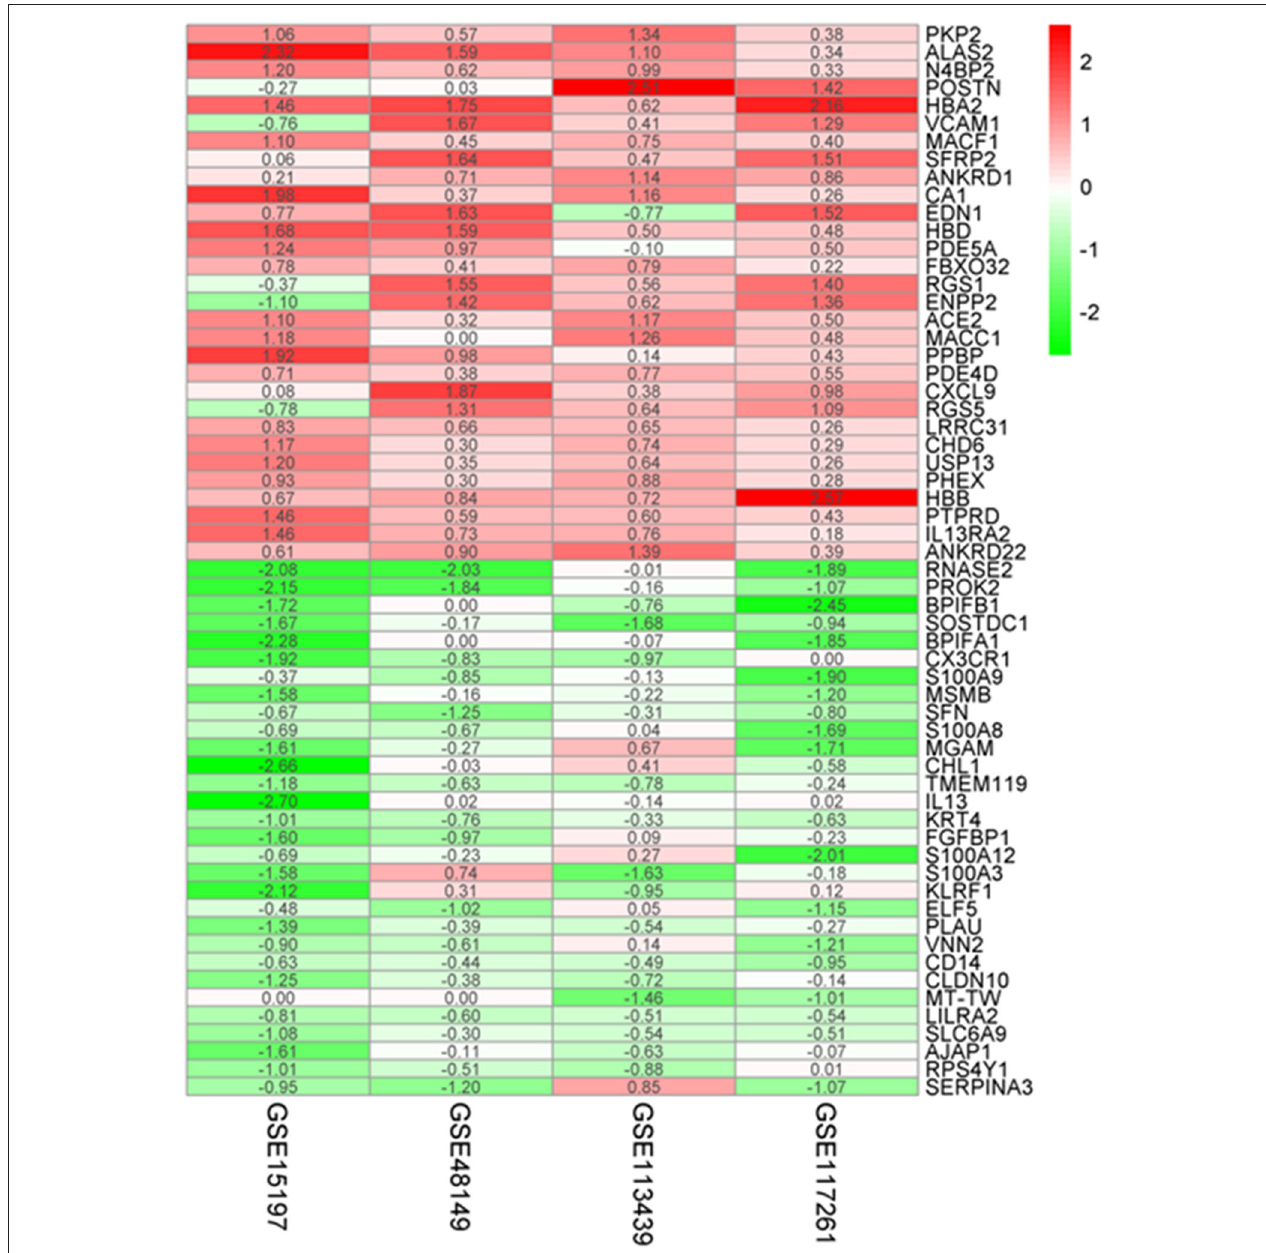
FIGURE 2 | Robust DEGs identified by RRA analysis. Heatmap of the four datasets showing the top 30 upregulated and 30 downregulated DEGs. The horizontal axis indicates the gene name, and the vertical axis represents a dataset. Red indicates that the gene is upregulated in the IPAH patients compared with the controls, and the green represents downregulation. The number in a cell indicates the logFC of each gene in a dataset. DEG, differentially expressed gene; RRA, robust rank aggregation.